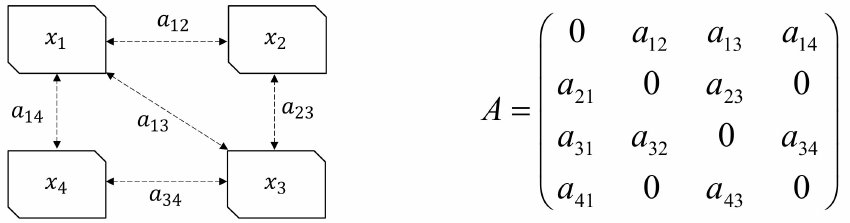
Figure 7. Example of a graph of four agents and their associated adjacency matrix. Developed from [38].